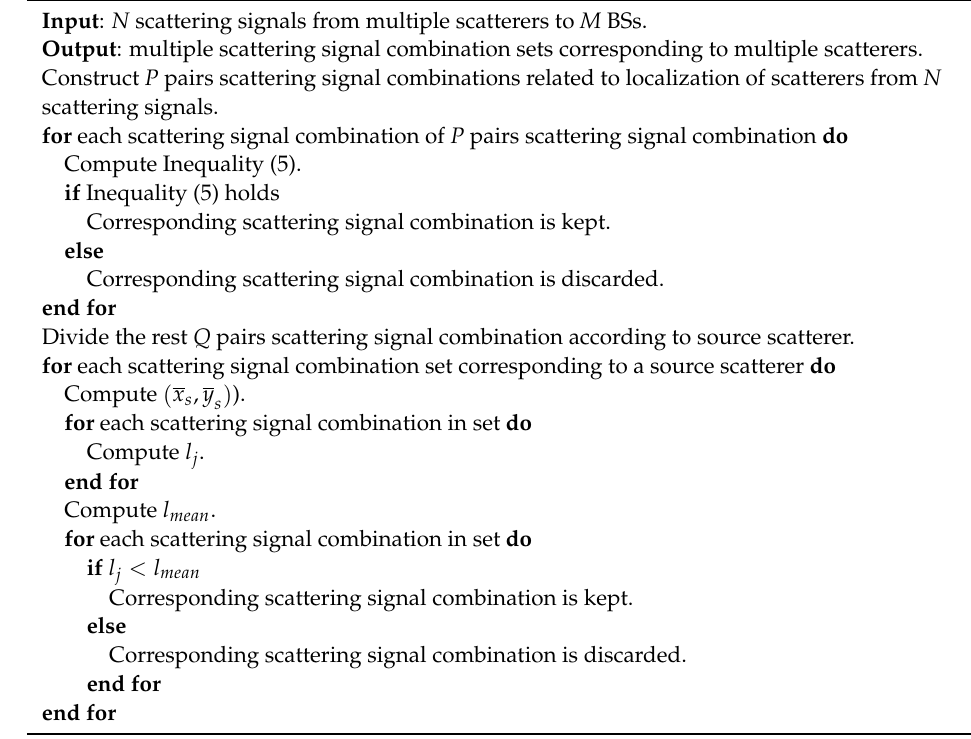
Algorithm 2 : First step of the identification